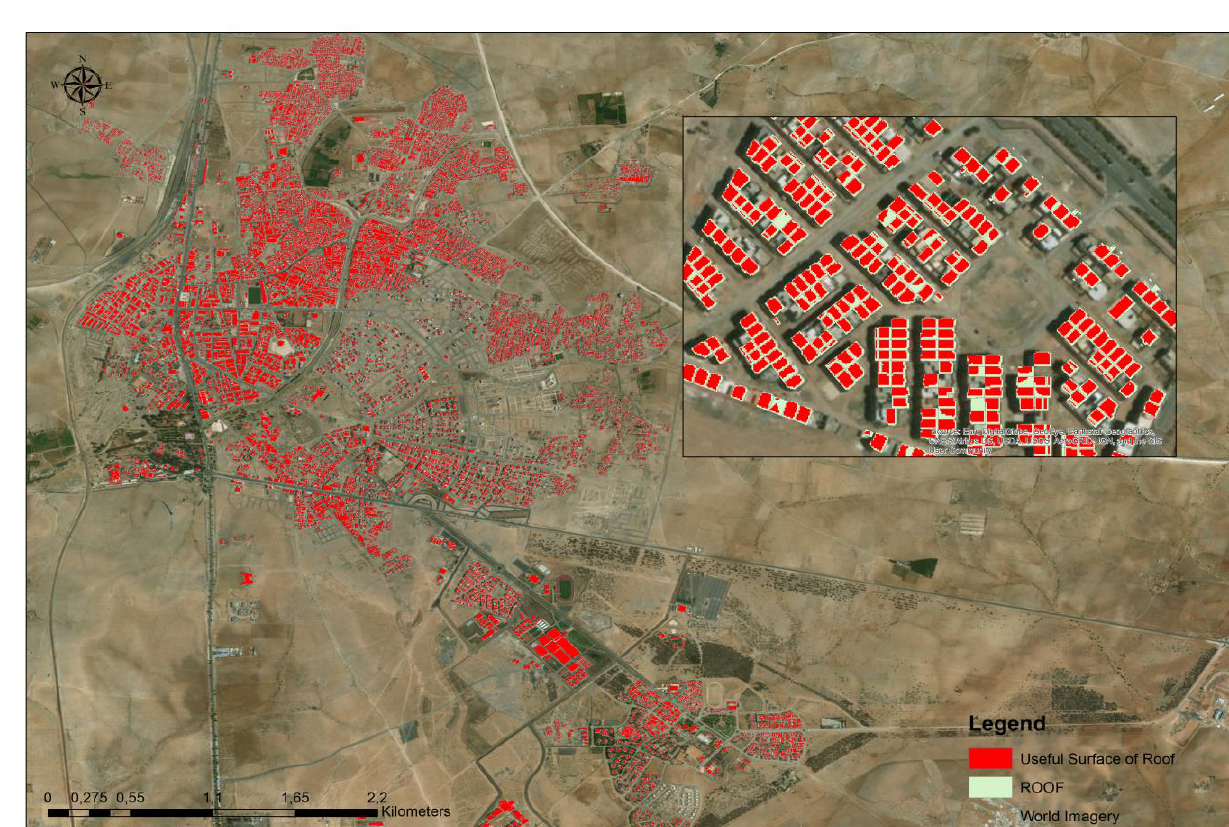
Figure 7. Example of useful surface compared to basic surfaces in